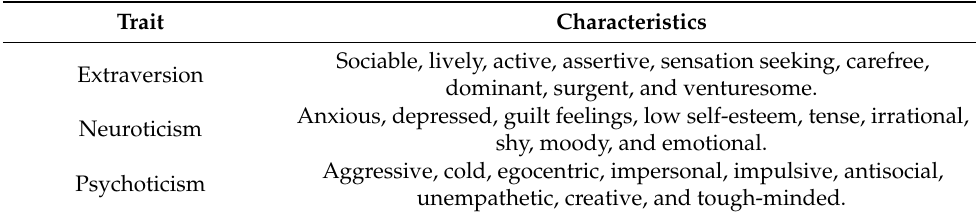
Table 1. Pen model traits and the corresponding characteristics [20]. Trait Characteristics Sociable, lively, active, assertive, sensation seeking, carefree, Extraversion dominant, surgent, and venturesome. Anxious, depressed, guilt feelings, low self-esteem, tense, irrational, Neuroticism shy, moody, and emotional. Aggressive, cold, egocentric, impersonal, impulsive, antisocial, Psychoticism unempathetic, creative, and